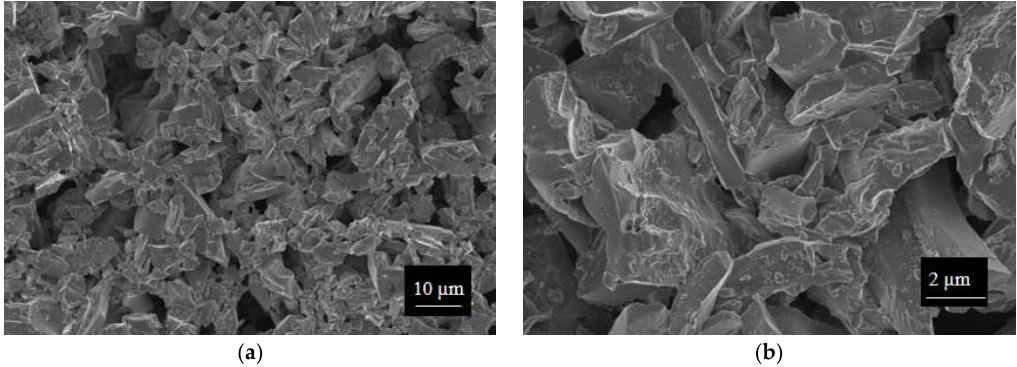
Figure 7. FESEM micrographs of SWP700 biochar sensor at different magnifications: ( a ) 2500×; ( b ) 10,000×. SWP700-PVP10% and SWP700-PVP20% film micrographs are illustrated in Figures 8 and 9. In